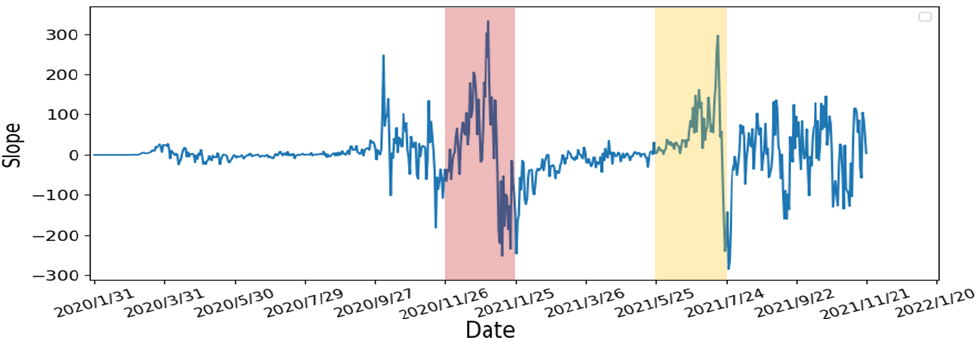
Figure 11. The slope of the UK’s daily confirmed cases between 31 January 2020 and 21 November